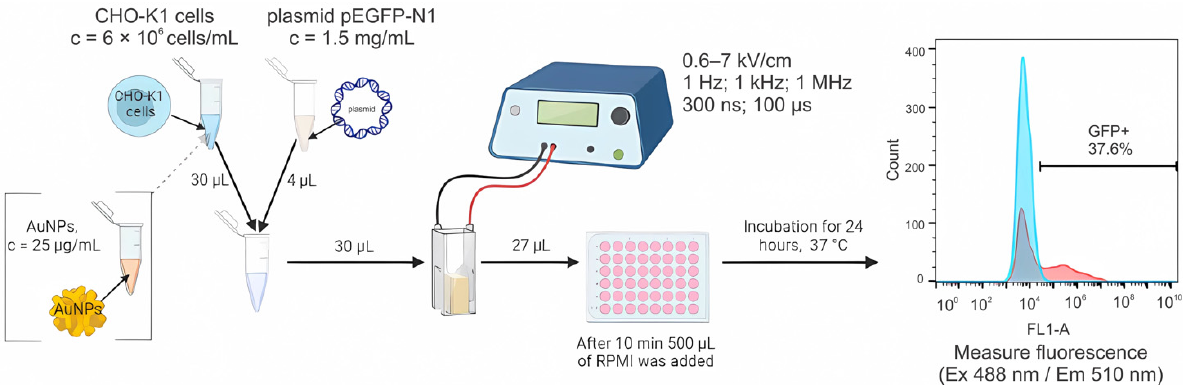
Figure 2. A scheme of electrotranfection experiments including gating strategy. Red color spectra indicate a shift in flureoscence intensity (GFP positive transfected cells); blue—non-electroporated cells.